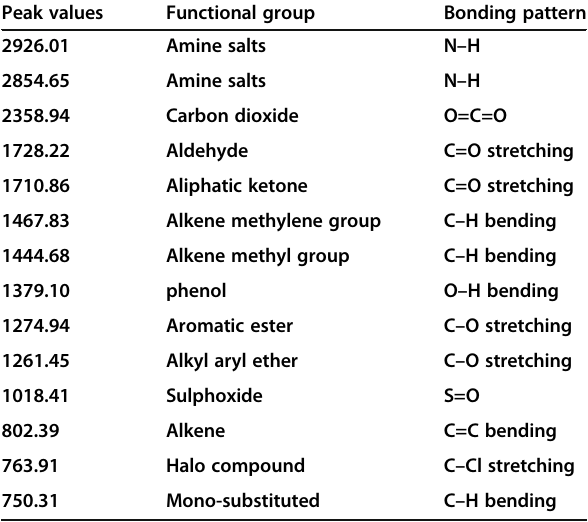
Table 2 FT-IR spectroscopy of methanol extract of C. vulgaris Peak